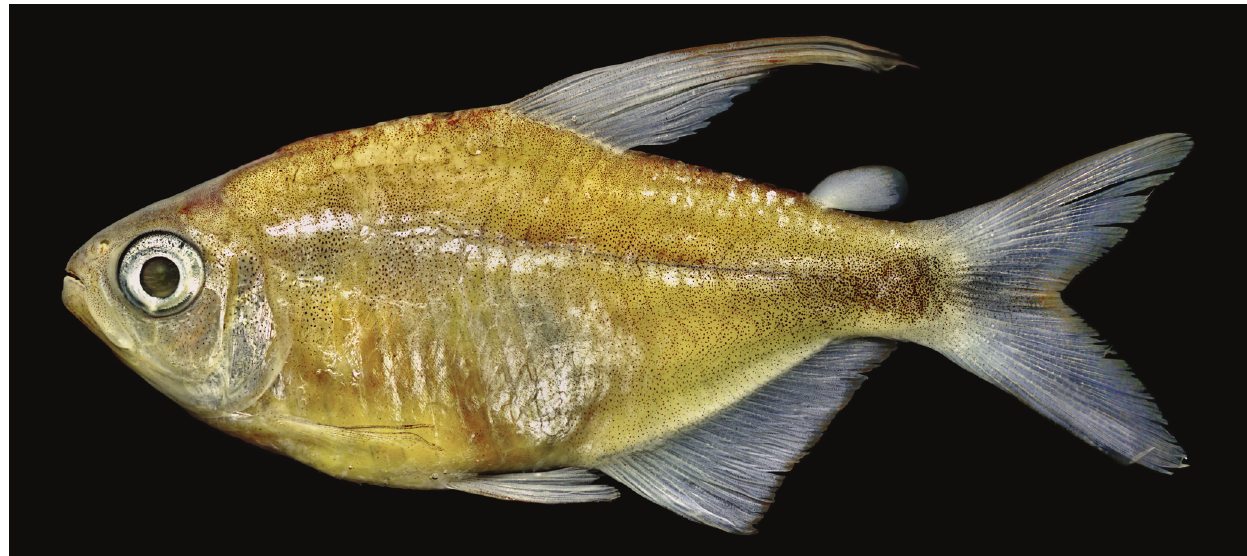
Fig. 6. Hyphessobrycon loweae , MZUSP 102816, 33.4 mm SL, topotype, male, Brazil, Mato Grosso State, ribeirão Xavante (rio Xingu